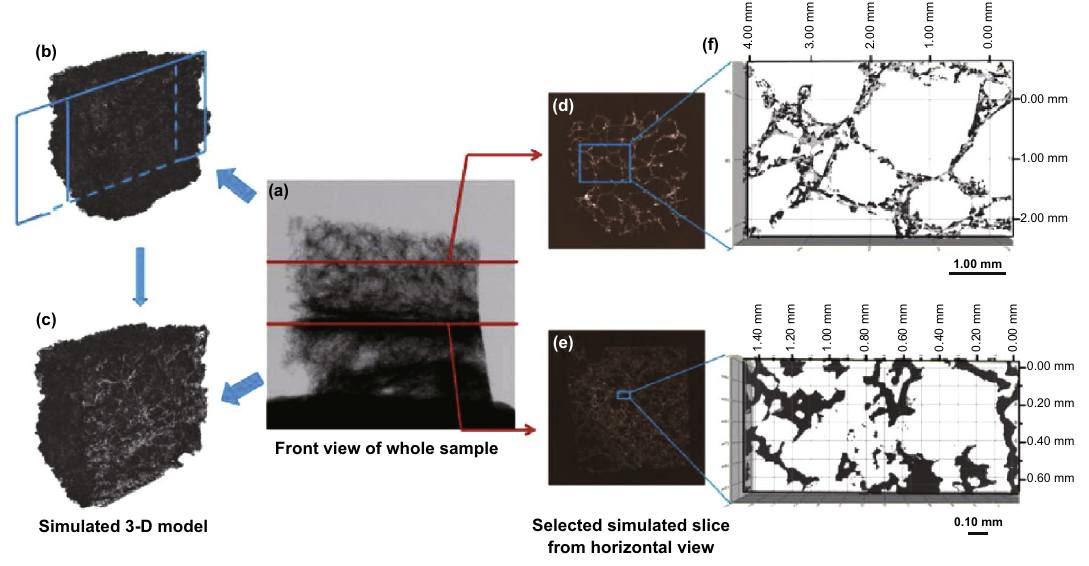
Fig. 16 The images and simulated model from X‑ray tomography: a front view of whole sample; b – c simulated 3D model of the whole sample and inner structure; d – g simulated slice at selected position from the horizontal view. Reproduced from Ref. [81] with permission from